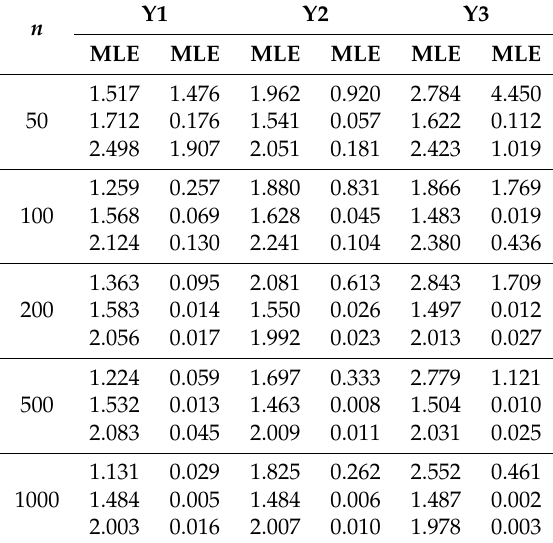
Table 5. Simulation study for the EMIEE model: MLEs and MSEs with the following sets of parameters: